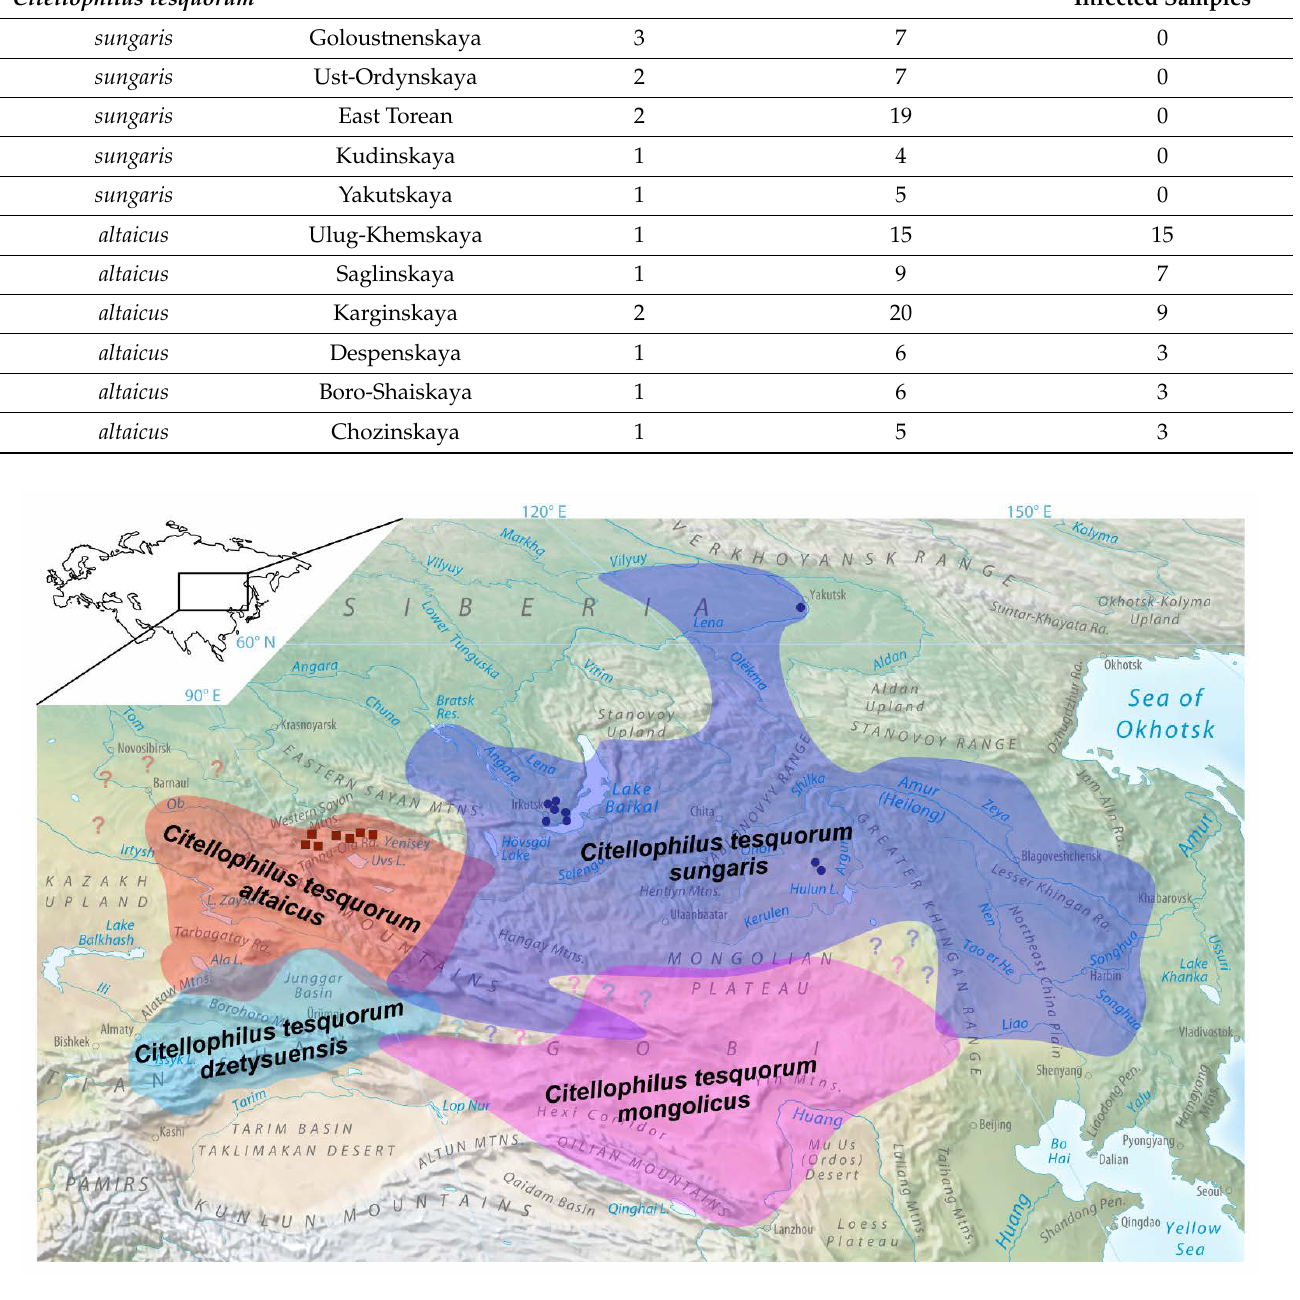
Table 1. Characteristics of data collection and Wolbachia infection.